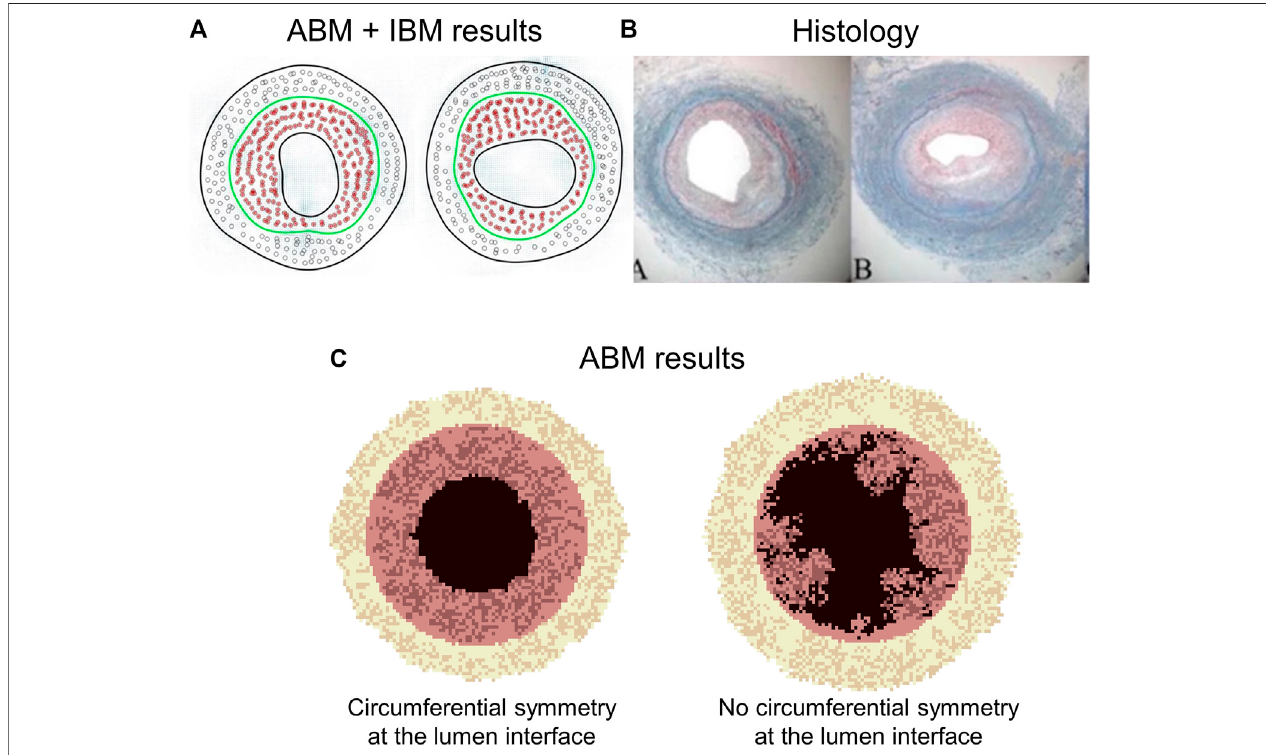
FIGURE 10 | Outputs of two multiscale agent-based modeling framework of vein graft adaptation by Garbey ’ s research group. (A) Results obtained by Garbey et al. (2019), when an immersed boundary method (IBM) module was added to simulate the vessel wall remodeling. (B) Histological images of rabbit vein graft (Conte et al., 2006). (C) Results obtained by Garbey et al. (2017). The results of panel (A) well resemble the histological images (B) . The model captures different possible patternsofneointimalhyperplasia, namelyavertical and horizontal con fi guration (panels (A,B) ).Panel (C) shows alimitationofthemodel byGarbeyetal.(2017). In particular, when the symmetry condition is removed, a non-realistic con fi guration of the lumen contour is obtained (e.g., detached elements, holes). Figures 9A,B Reprinted with permission from Garbey et al. (2019) (http://creativecommons.org/licenses/by/4.0/). Figure 9C reprinted with permission from Garbey et al.